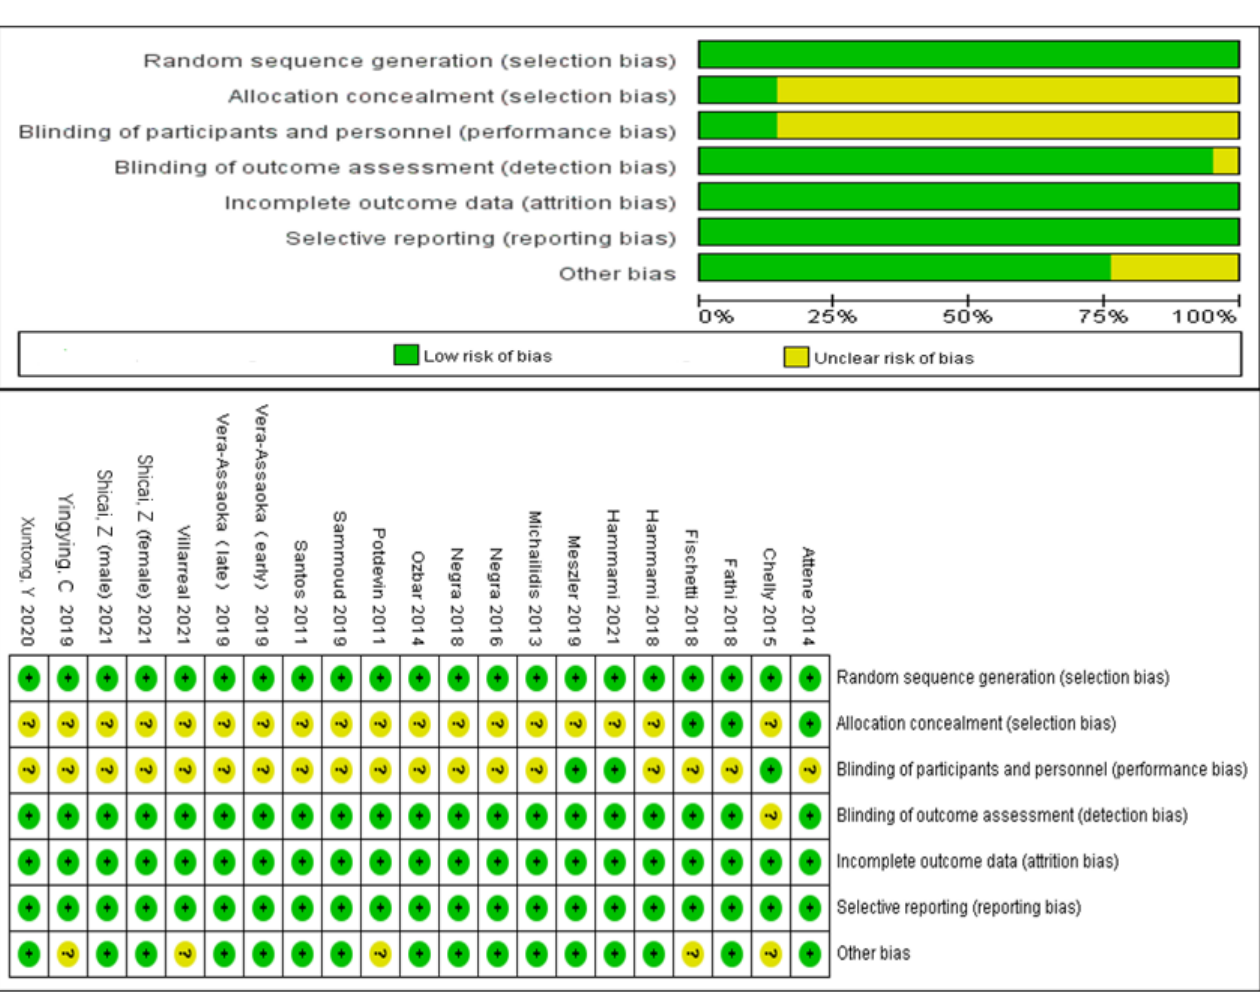
Figure 3. Judgments about each risk-of-bias item for each included study and risk-of-bias item presented as percentages across all included studies.